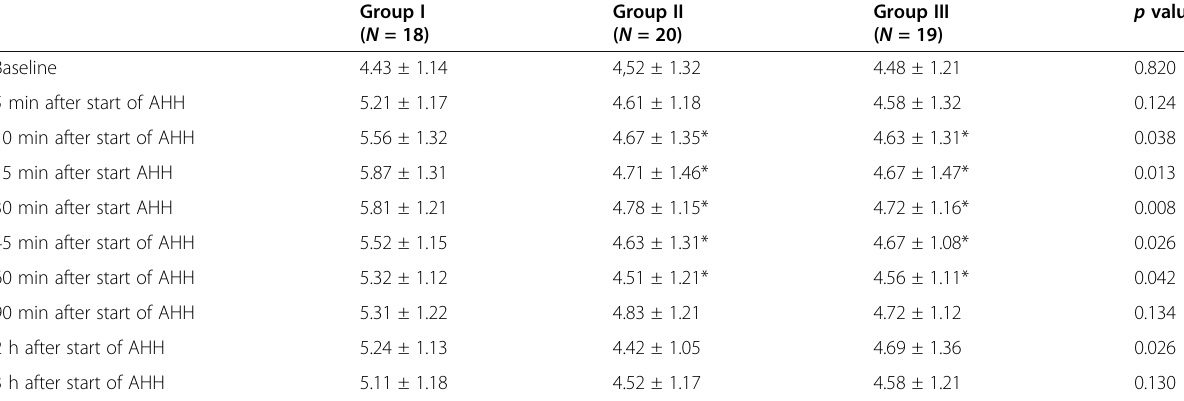
Table 3 Cardiac output expressed in l/min in the three study